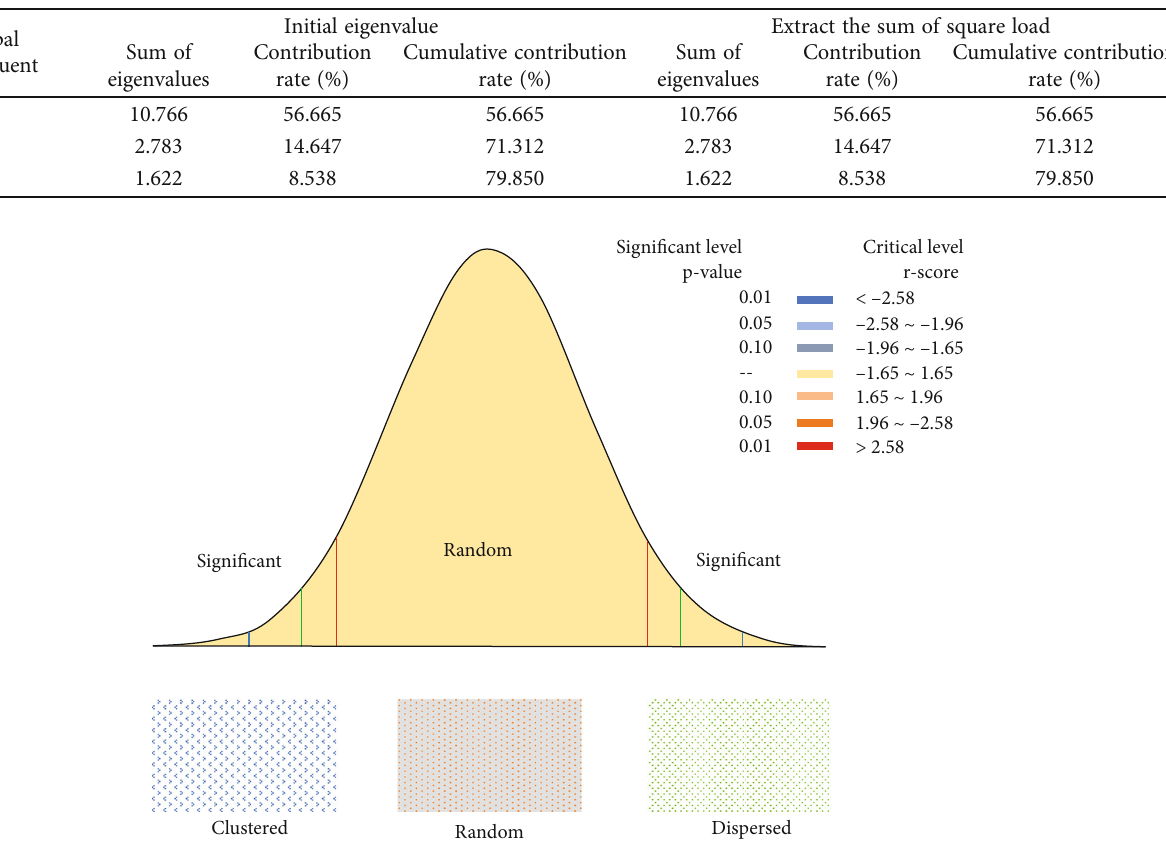
Figure 6: Spatial cluster diagram of nearest distance